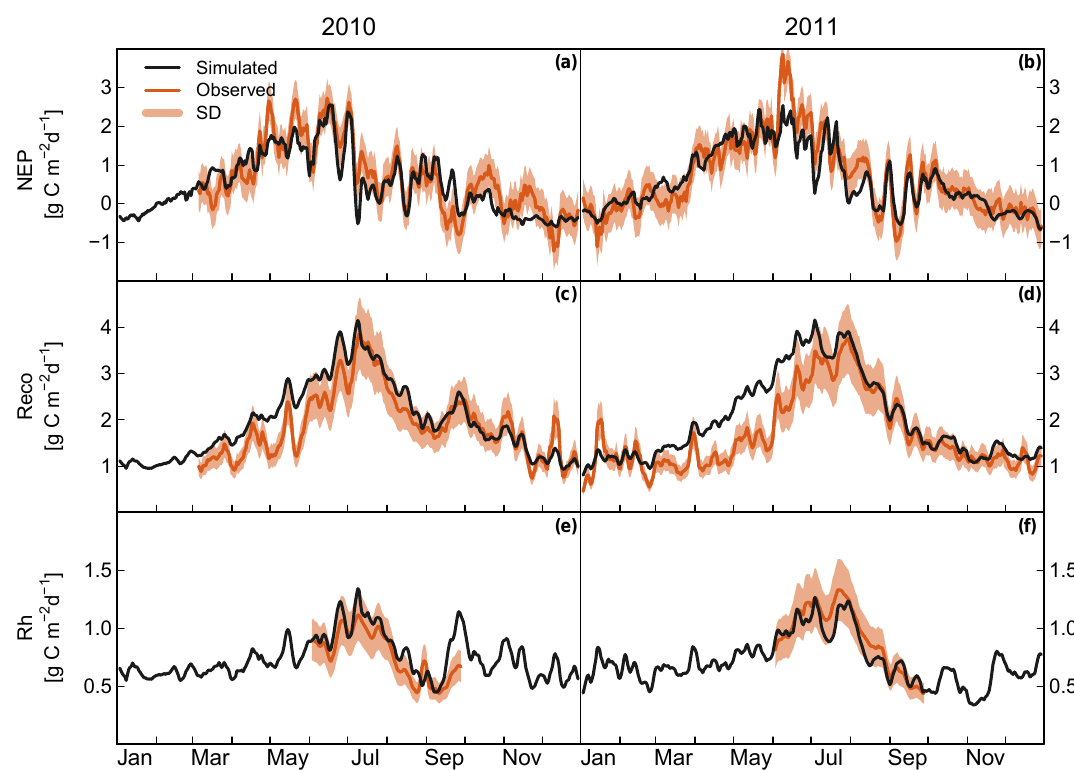
Figure 2. Seasonality of observed and simulated daily net ecosystem productivity (NEP, a and b ), ecosystem respiration (Reco, c and d ) and heterotrophic respiration (Rh, e and f ) in 2010 and 2011. Data are 5 day moving averages. Error estimates (SD) for observational data are given by the lighter colored areas around the